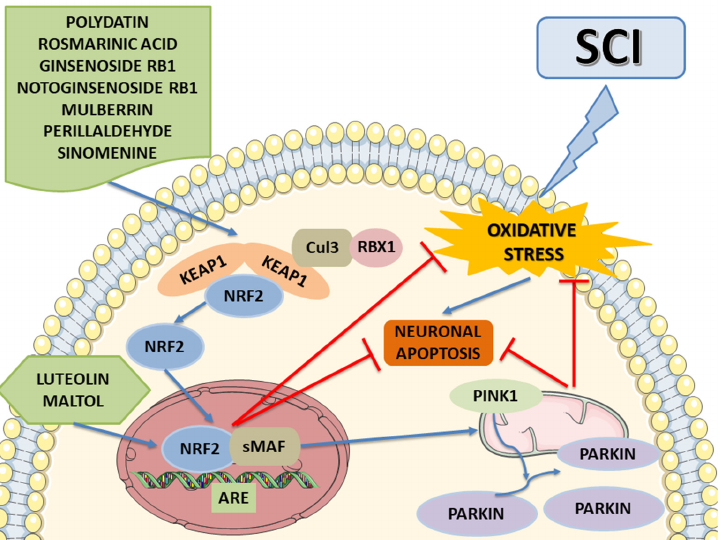
Figure 4. The potential molecular mechanism of natural compounds on SCI. These natural com- pounds can activate the expression of Nrf2 and facilitate Nrf2 ′ s translocation from the cytosol to the nuclear, thus inhibiting oxidative stress and protecting from neuronal apoptosis. Moreover, some of these promote mitophagy via enhancing the Nrf2/PINK1/Parkin pathway, suppressing neuronal apoptosis in SCI. The image was created using the image bank of Servier Medical Art (Available online: http://smart.servier.com/, accessed on 15 November 2022), licensed under a Creative